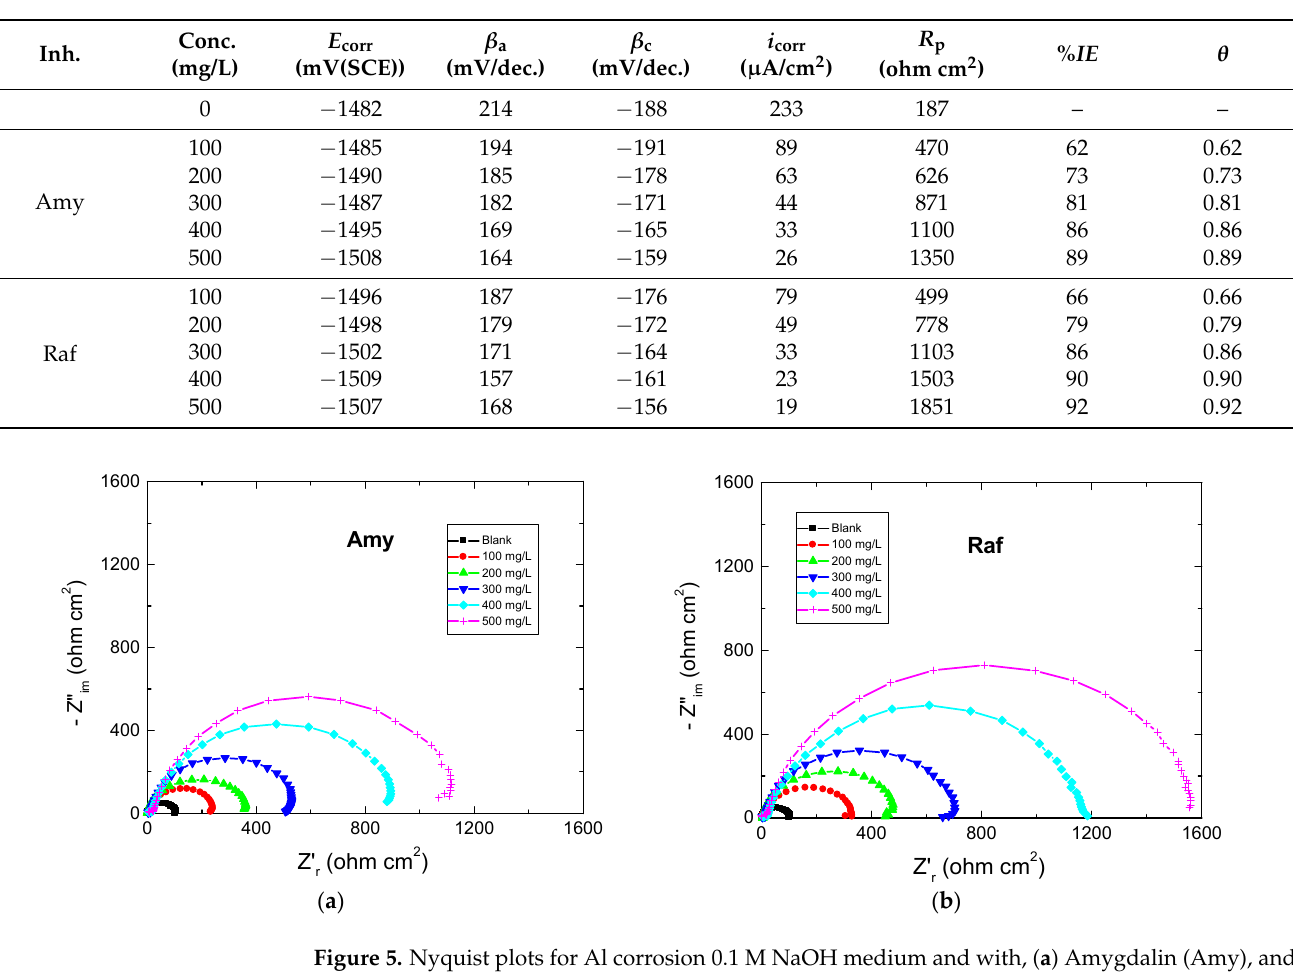
Table 2. Values of PDP parameters for Al corrosion in 0.1 M NaOH medium and with Amy and Raf at 298 K.